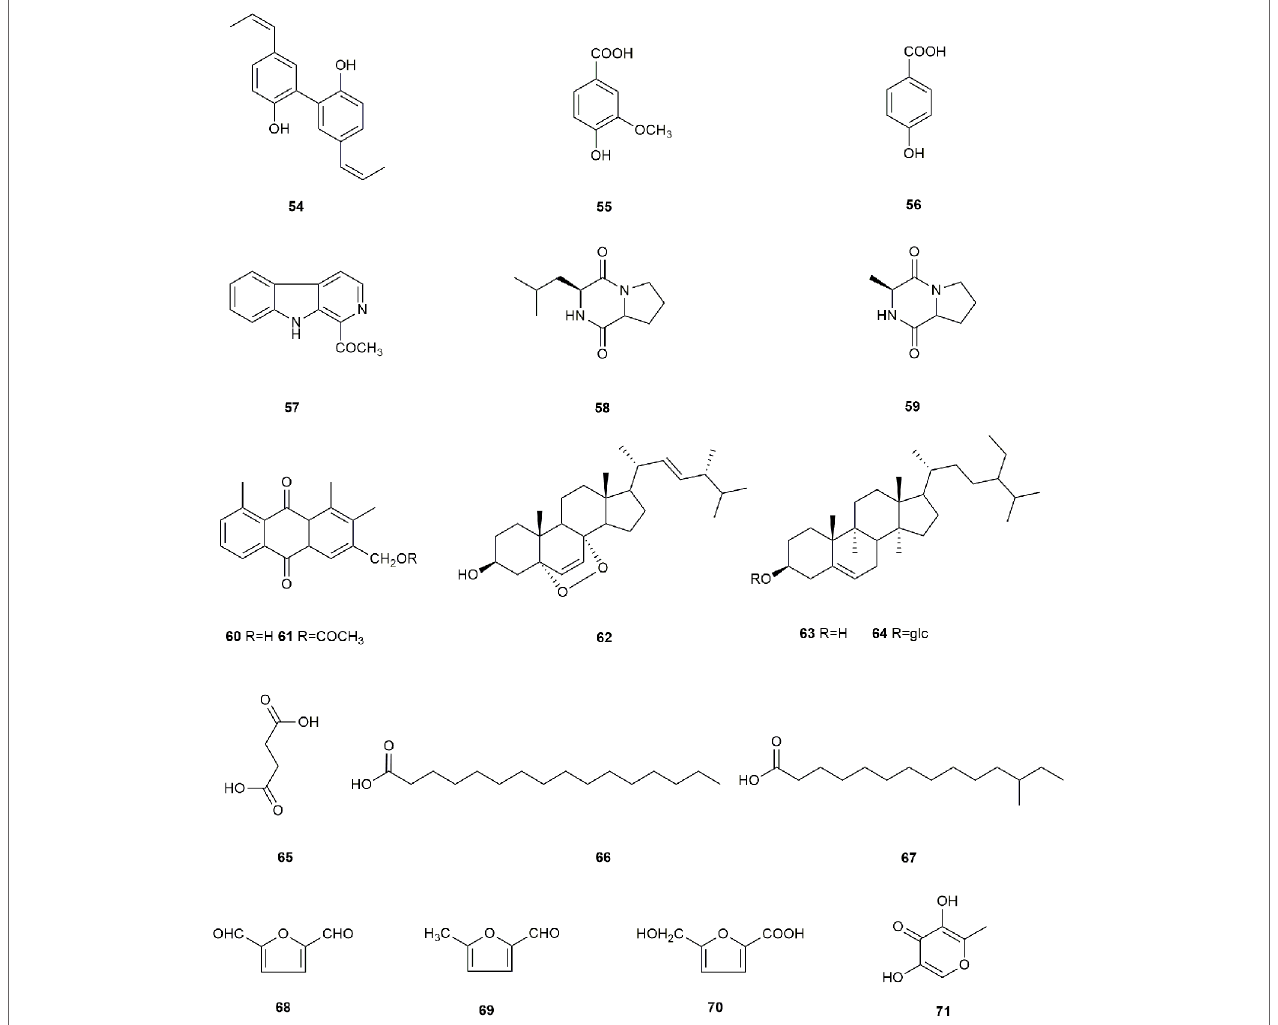
FIGURe 5 | The structures of other compounds from S.